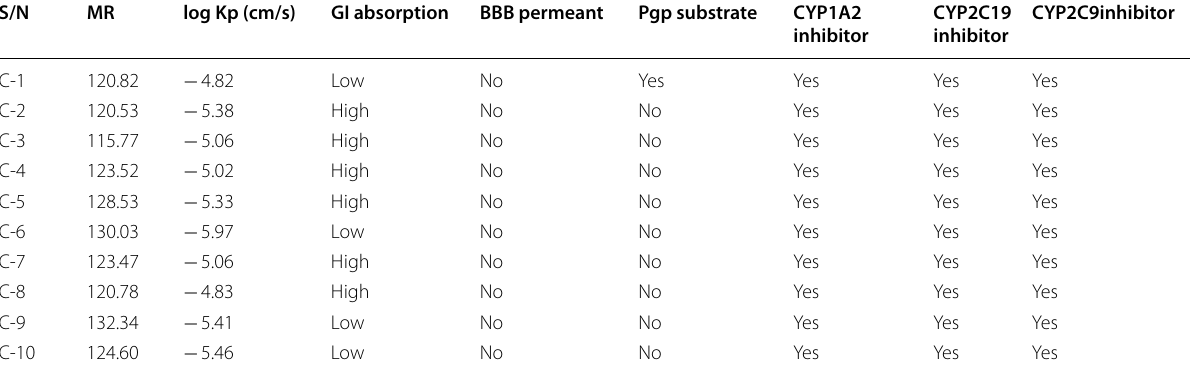
MR molar refractivity, log Kp log of skin permeability, GI gastrointestinal absorption, BBB blood–brain barrier, Pgp penetration permeability glycoprotein substrate, CYP450 cytochrome P450 enzymes; CYP1A2, CYP2C9, and CYP2C19 inhibitors